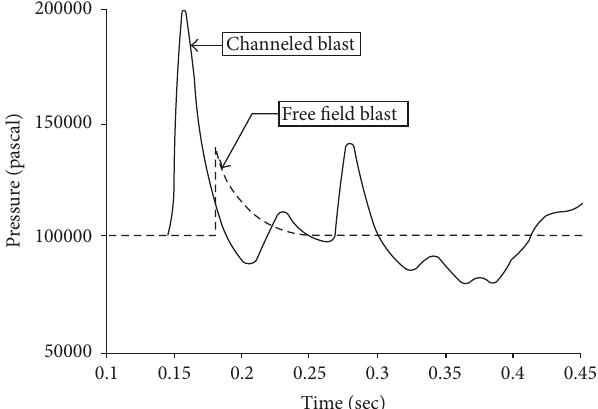
Figure 4: Comparison of free air field and street channeled blast pressure-time